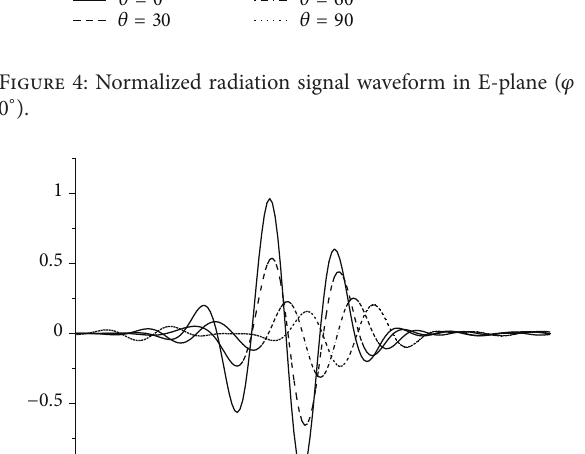
Figure 1: Geometry of the original Vivaldi antenna: (a) top view, (b) central layer (feed), and (c) bottom view.